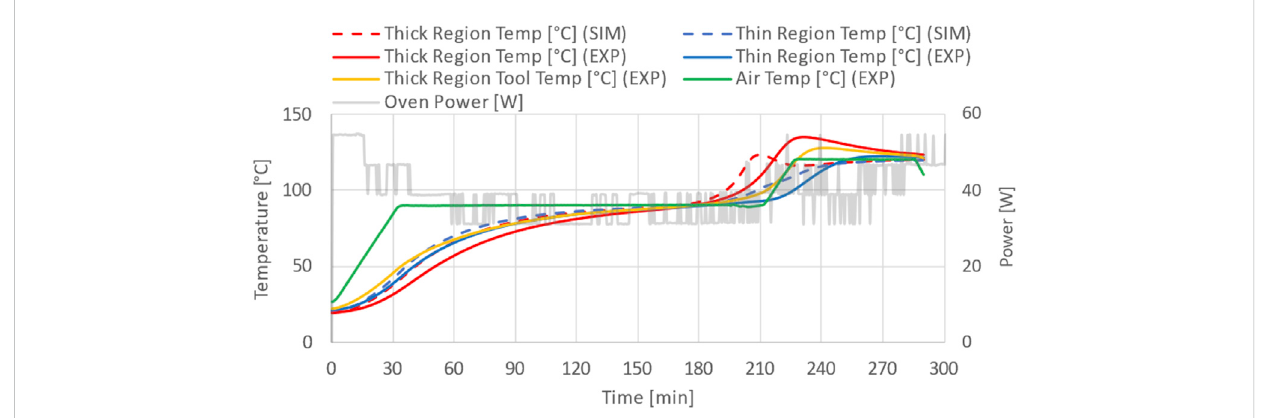
FIGURE 5 Temperature as simulated and experimentally measured at mid-thickness in thick and thin region for single zone cure, accompanied by the power usage of the oven as measured.